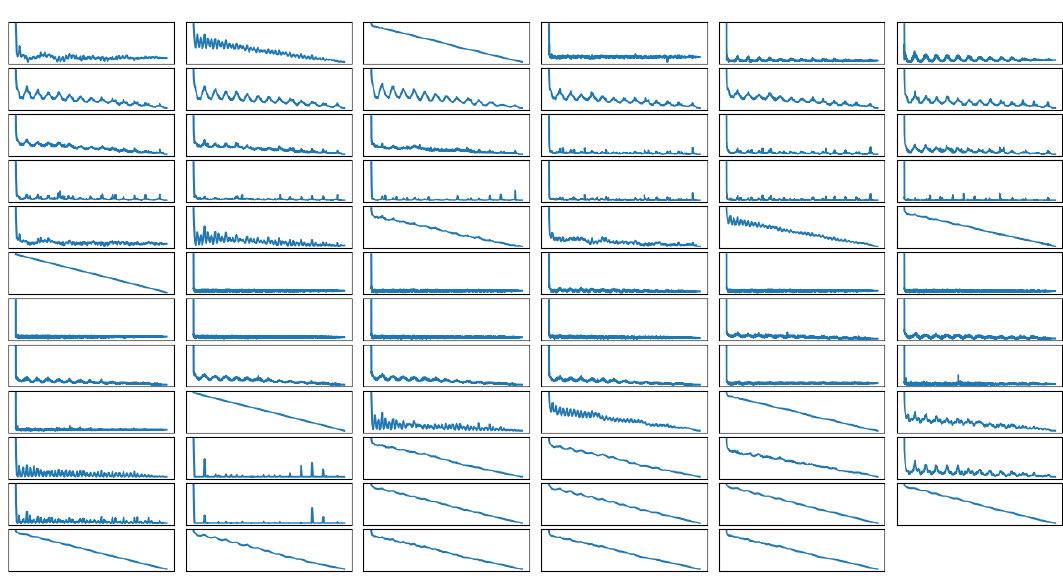
Figure 6. Autocorrelation for the final selected